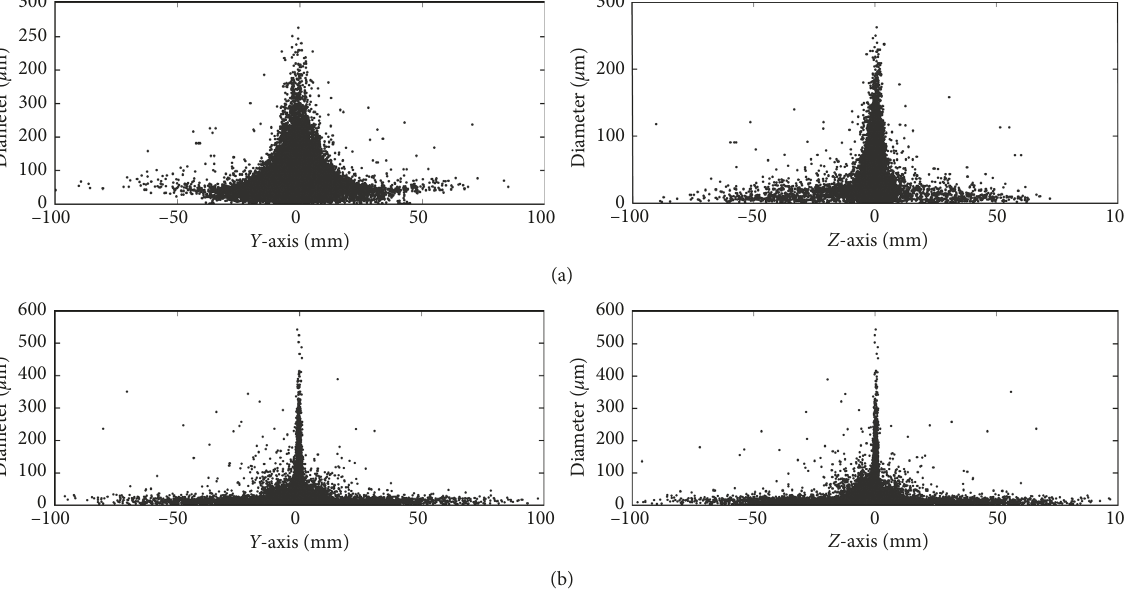
Figure 10: Droplet size and spatial distributions. (a) Droplet spatial and size distributions for multiorifice nozzle: Y -axis (left); Z -axis (right). (b) Droplet spatial and size distributions for single-hole nozzle: Y -axis (left); Z -axis